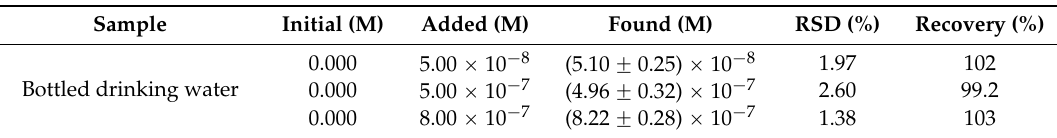
Table 1. Addition and recovery of Bisphenol A from the bottled drinking water by the proposed method at AuNP/PVP/PGE. RSD = relative standard